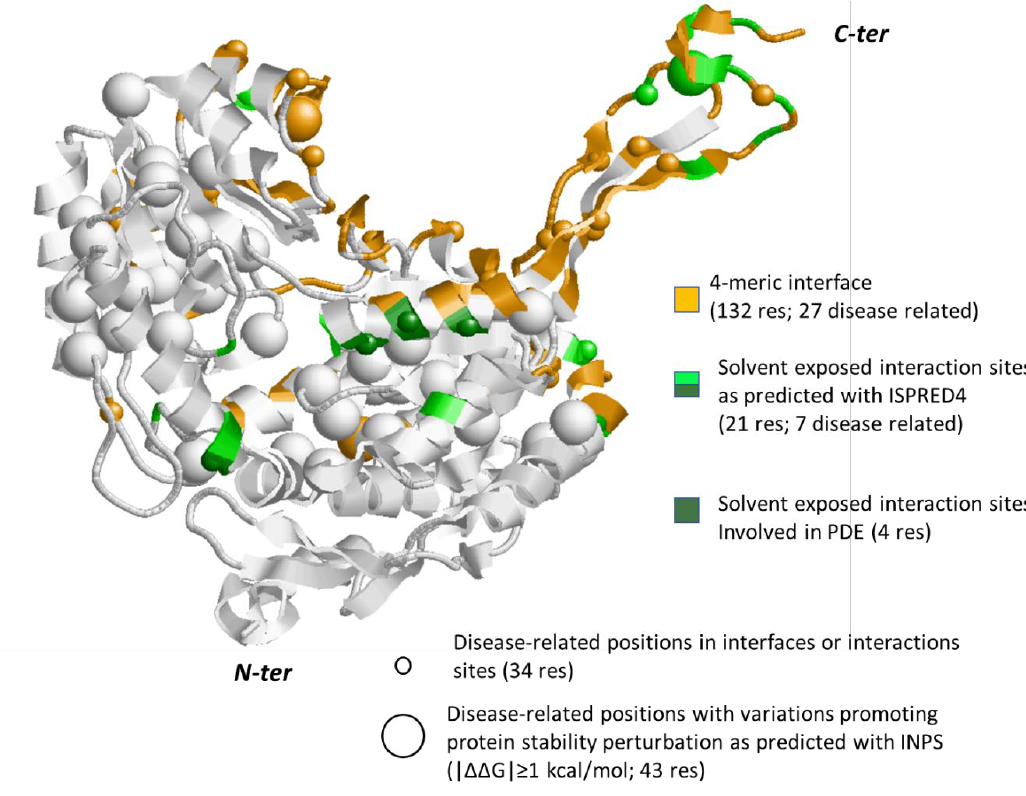
Figure 5. Monomeric subunit of human ALDH7A1 protein (PDB code: 4ZUL.A). Interaction surface in the tetramer as derived from the crystallographic coordinates is in orange. Interaction sites out the tetrameric interface, as predicted with ISPRED4, are in green. Positions in these regions carrying disease related variations (Table S2) are highlighted with small spheres. Big spheres highlight positions in the protein carrying disease related variations (Table S2, for details) and promoting a large variance of folding free energy, as predicted with INPS [26]. Grey color: the background protein backbone.